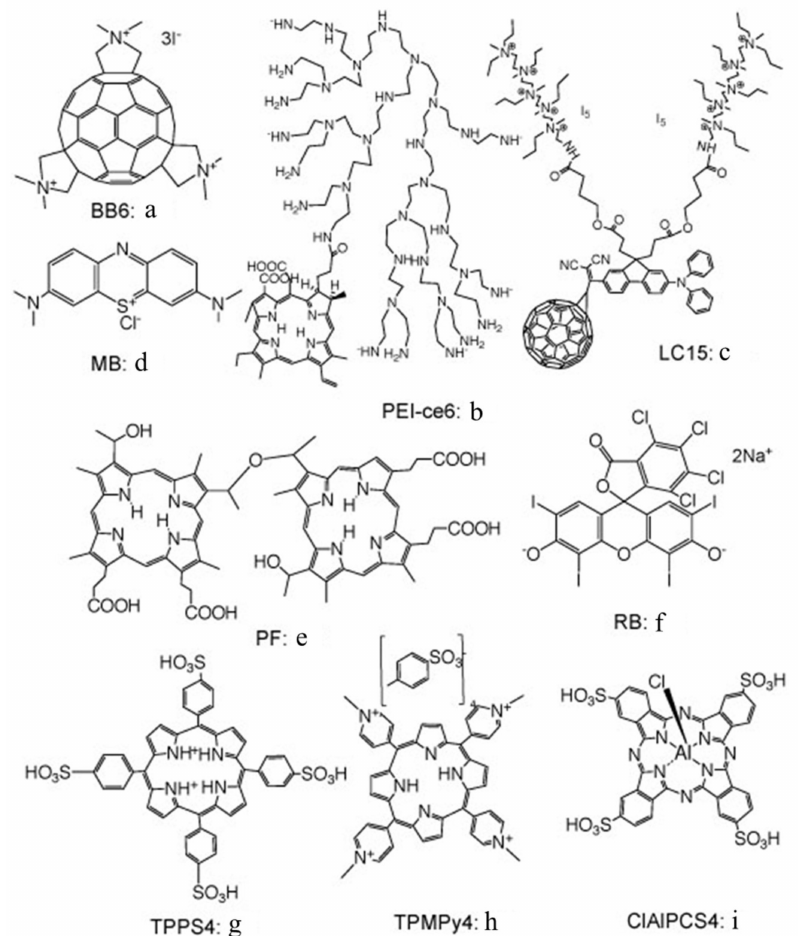
Figure 2. Chemical structures of several of the PS used in this paper. a, Triscationic fullerene BB6; b, conjugate between polyethylenimine and chlorin(e6) PEI-ce6; c, decacationic fullerene LC15; d, phenothiazinium methylene blue MB; e, hematoporphyrin derivative Photofrin PF; f, halogenated xanthene Rose Bengal RB; g, tetraanionic porphyrin TPPS4; h, tetracationic porphyrin TPMPy4; i, tetraanionic phthalocyanine